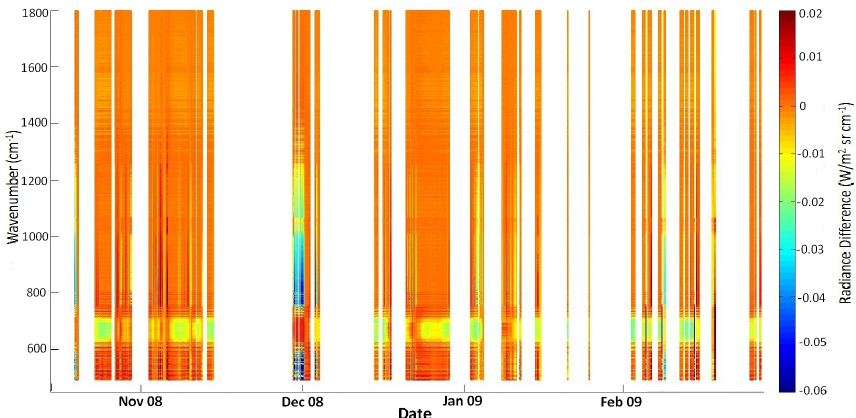
Fig. 8. Hourly-averaged coincident radiance difference measurements (P-AERI − E-AERI) from 22 October 2008 to 5 April 2009. Only the longwave radiances are shown for clarity. White spaces correspond to periods with no measurement overlap due to precipitation or instrument